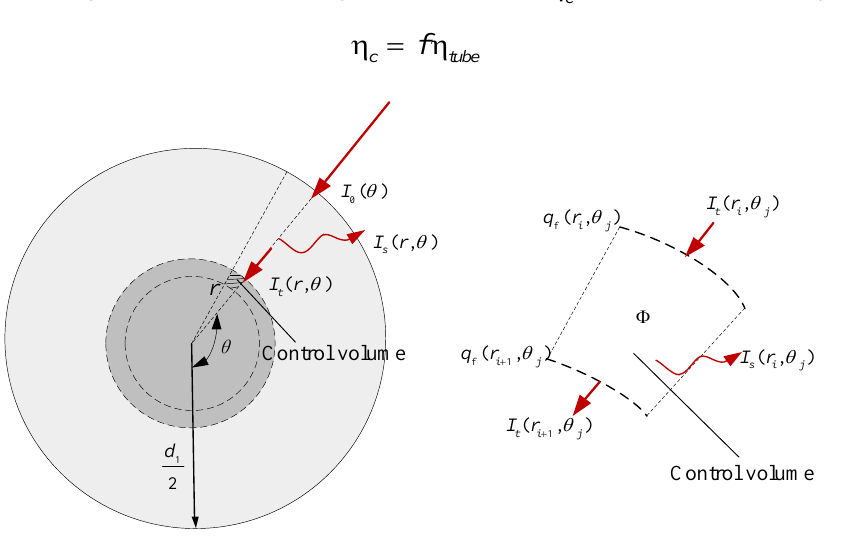
Figure 3. The solar radiation transfer inside the tube of the